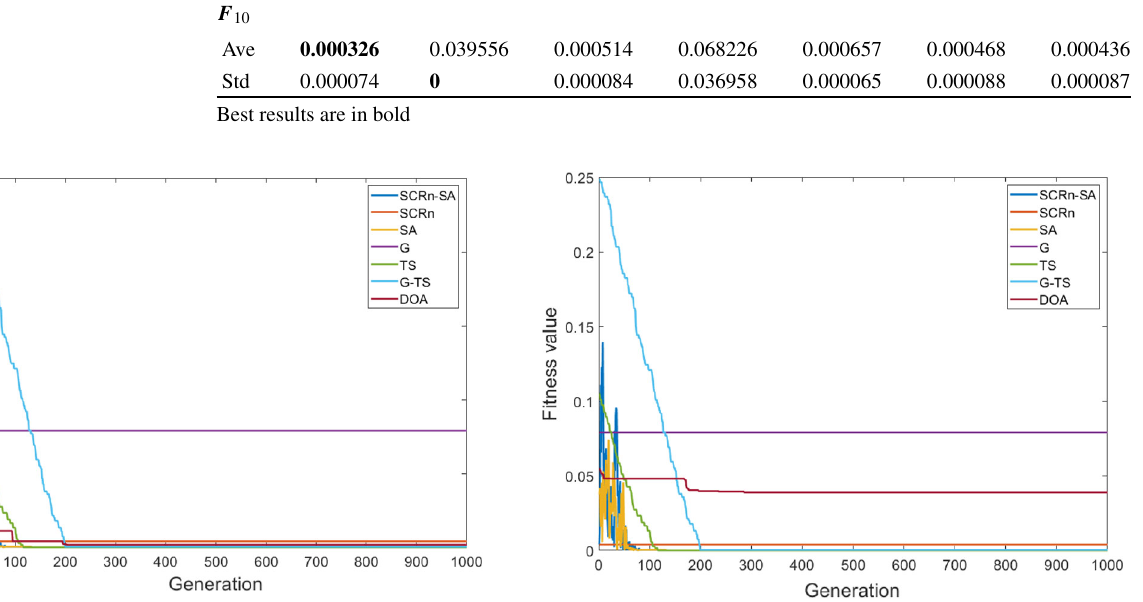
Fig. 8 Convergence curve for F 2 Fig. 9 Convergence curve for F